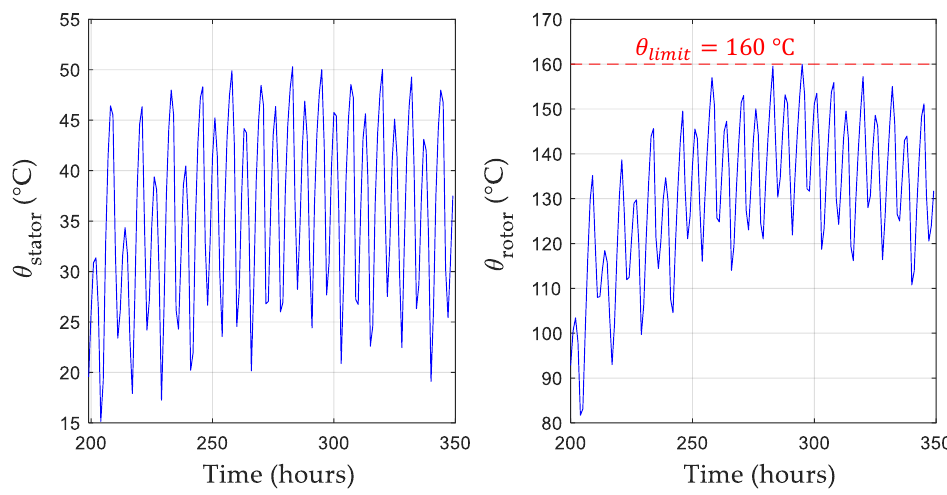
Figure 11. Temperature elevation in the stator and rotor windings of the optimal generator.